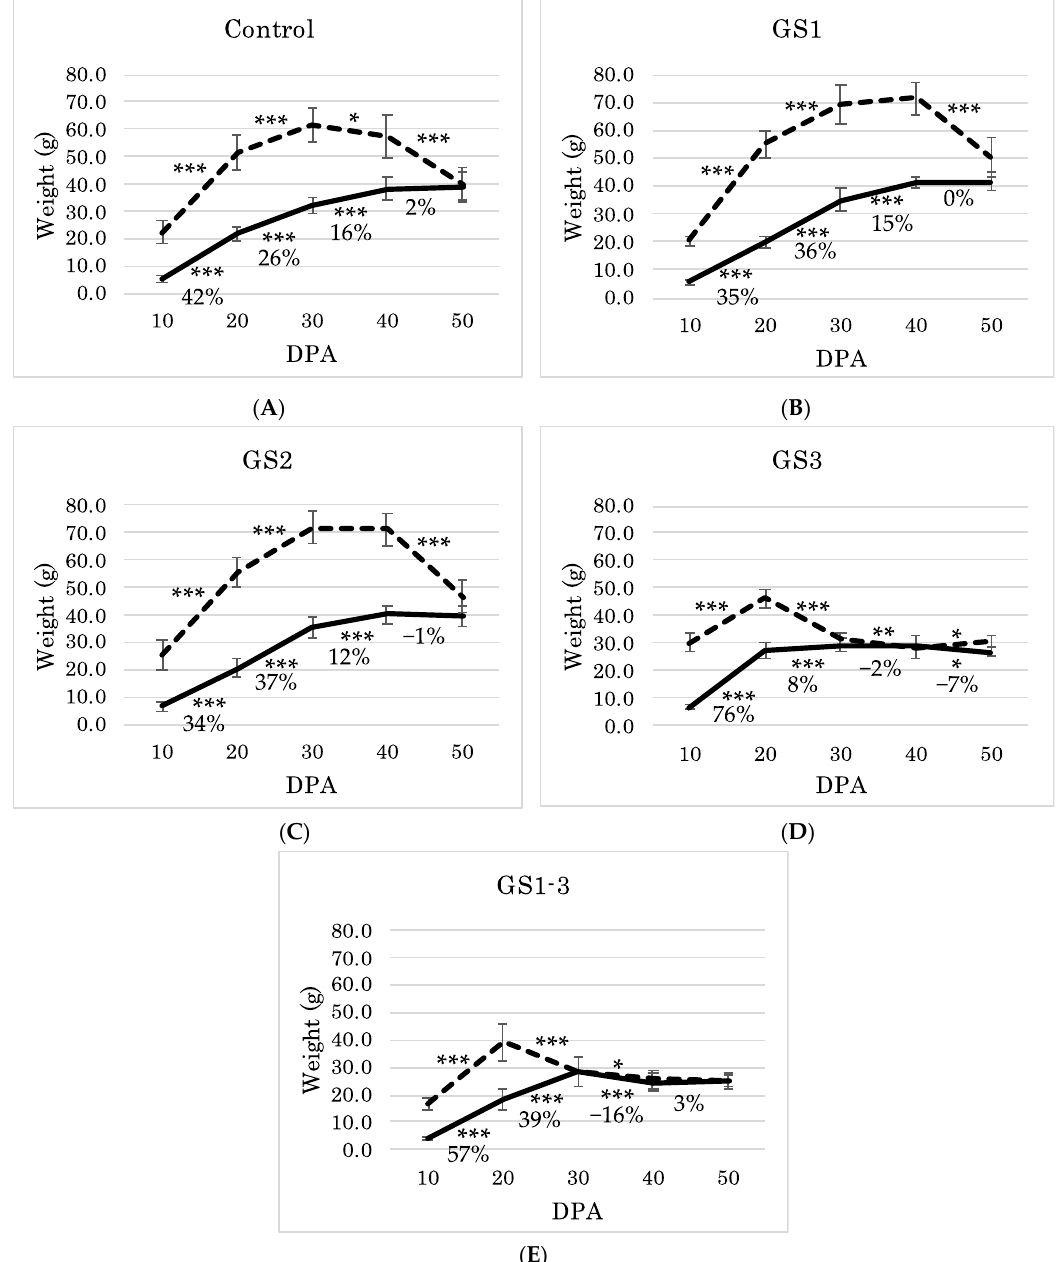
Figure 6. Time-series transition of seed maturity every 10 days from flowering date based on fresh weight (- - -) and dry weight (—). * Significant differences between pairs of values (* p = 0.05; ** p = 0.01; *** p = 0.001). Bonferroni’s correction was applied to control p -values in multiple comparisons. The percentages indicate the proportion of dry weight at each point calculated with an average dry weight at 50 DPA of 100%. ( A ) Control and ( B – E ) samples treated at high temperature during ( B ) GS1, ( C ) GS2, ( D ) GS3, and ( E ) all growth stages (GS1–3). n = 3.